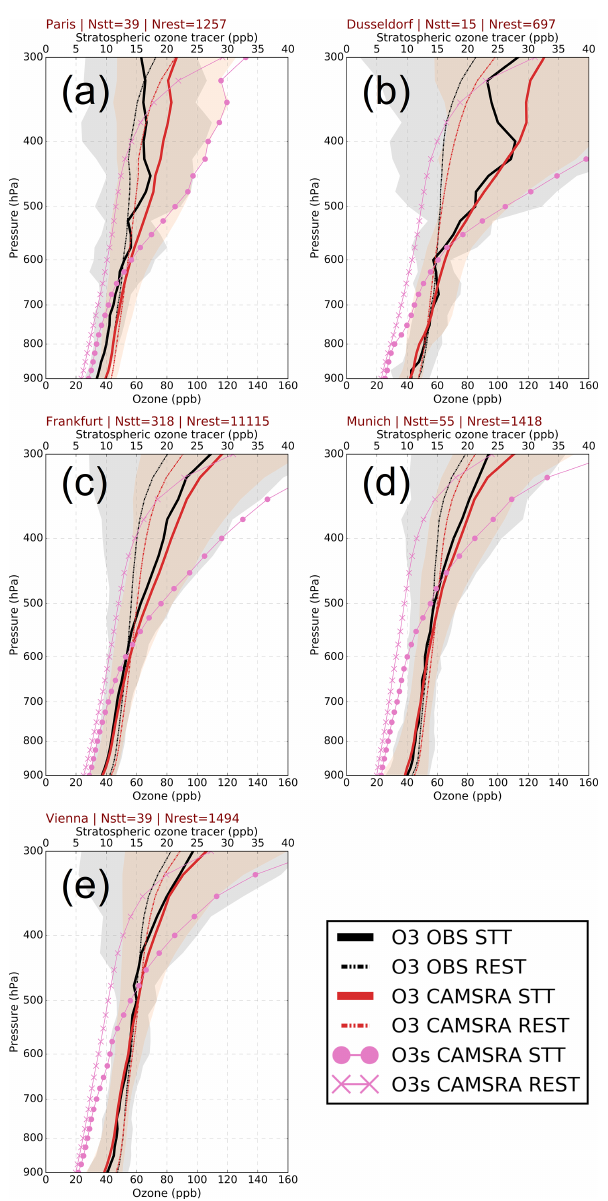
Figure 5. Vertical profiles of observed (black) and CAMSRA (red) ozone concentrations (ppb) during STT events (thick solid line) and during the rest of the events (thin dashed line) at the IAGOS air- ports of (a) Paris (France), (b) Düsseldorf (Germany), (c) Frankfurt (Germany), (d) Munich (Germany), and (e) Vienna (Austria). Also shown are the vertical profiles of stratospheric ozone tracer concen- trations (ppb) during STT (pink circles) and the rest of the events (pink crosses). The grey and sandy brown areas depict the ± 1 stan- dard deviation of ozone vertical profiles during STT events in ob- servations and CAMSRA, respectively. Keep in mind that O 3 and O 3s concentrations are presented on different horizontal axes.